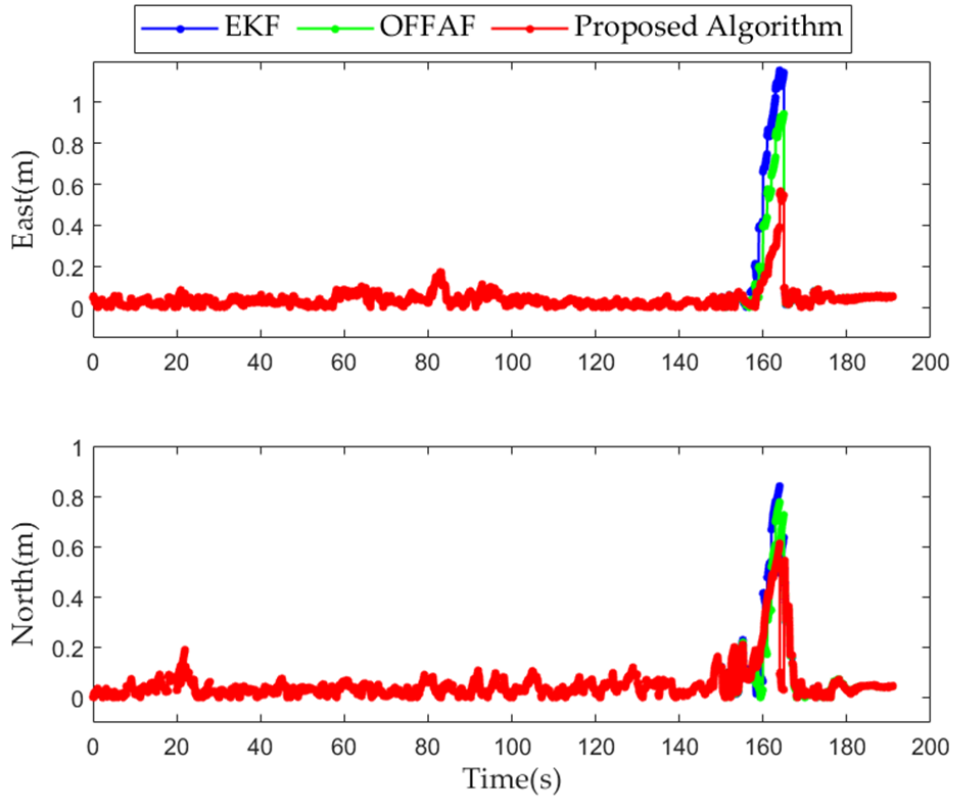
Figure 14. Positioning errors in the east and north for the EKF, OFFAF and the proposed algorithm.